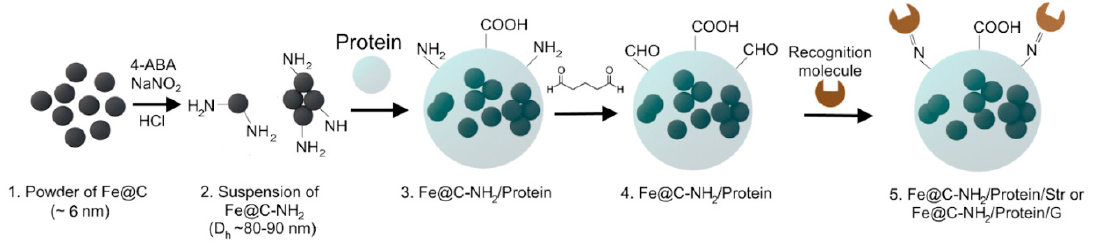
Figure 1. Synthesis of Fe@C-NH 2 /Protein/Str and Fe@C-NH 2 /Protein/G. 4-ABA-4- aminobenzylamine.